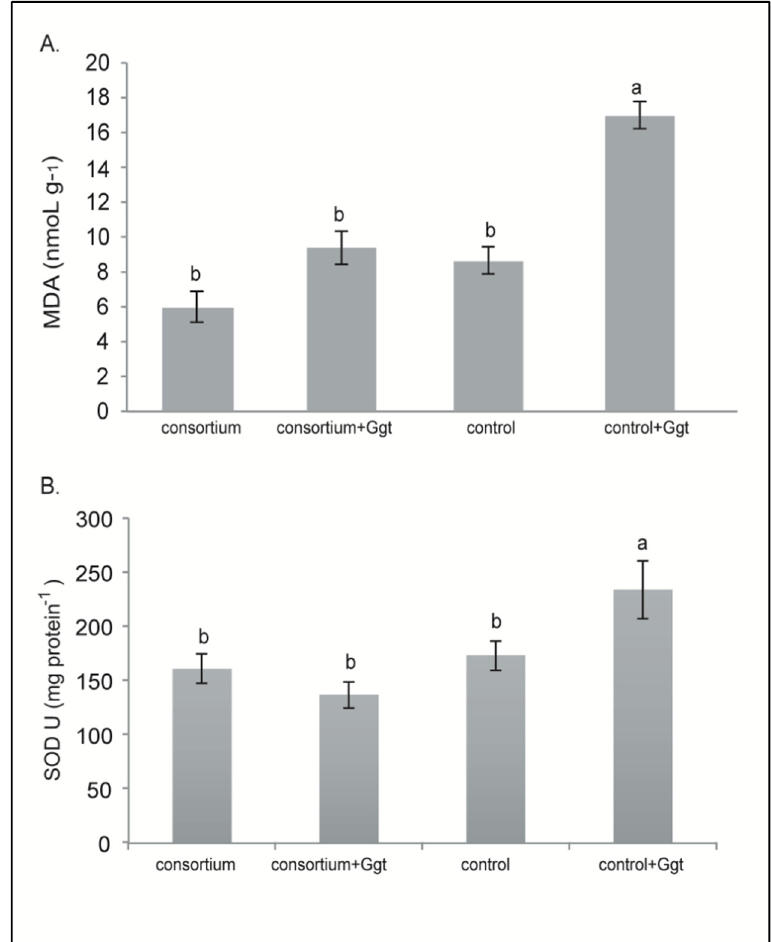
Figure 5. ( A ) Lipid peroxidation measured as TBARS (thiobarbituric-acid-reactive substance) accu- mulation; and ( B ) superoxide dismutase activity (SOD) in roots of wheat in the field assay. Tukey’s test was used to compare the means of the treatments; values followed by the same letter indicate a nonsignificant difference at p < 0.05 ( n = 5).